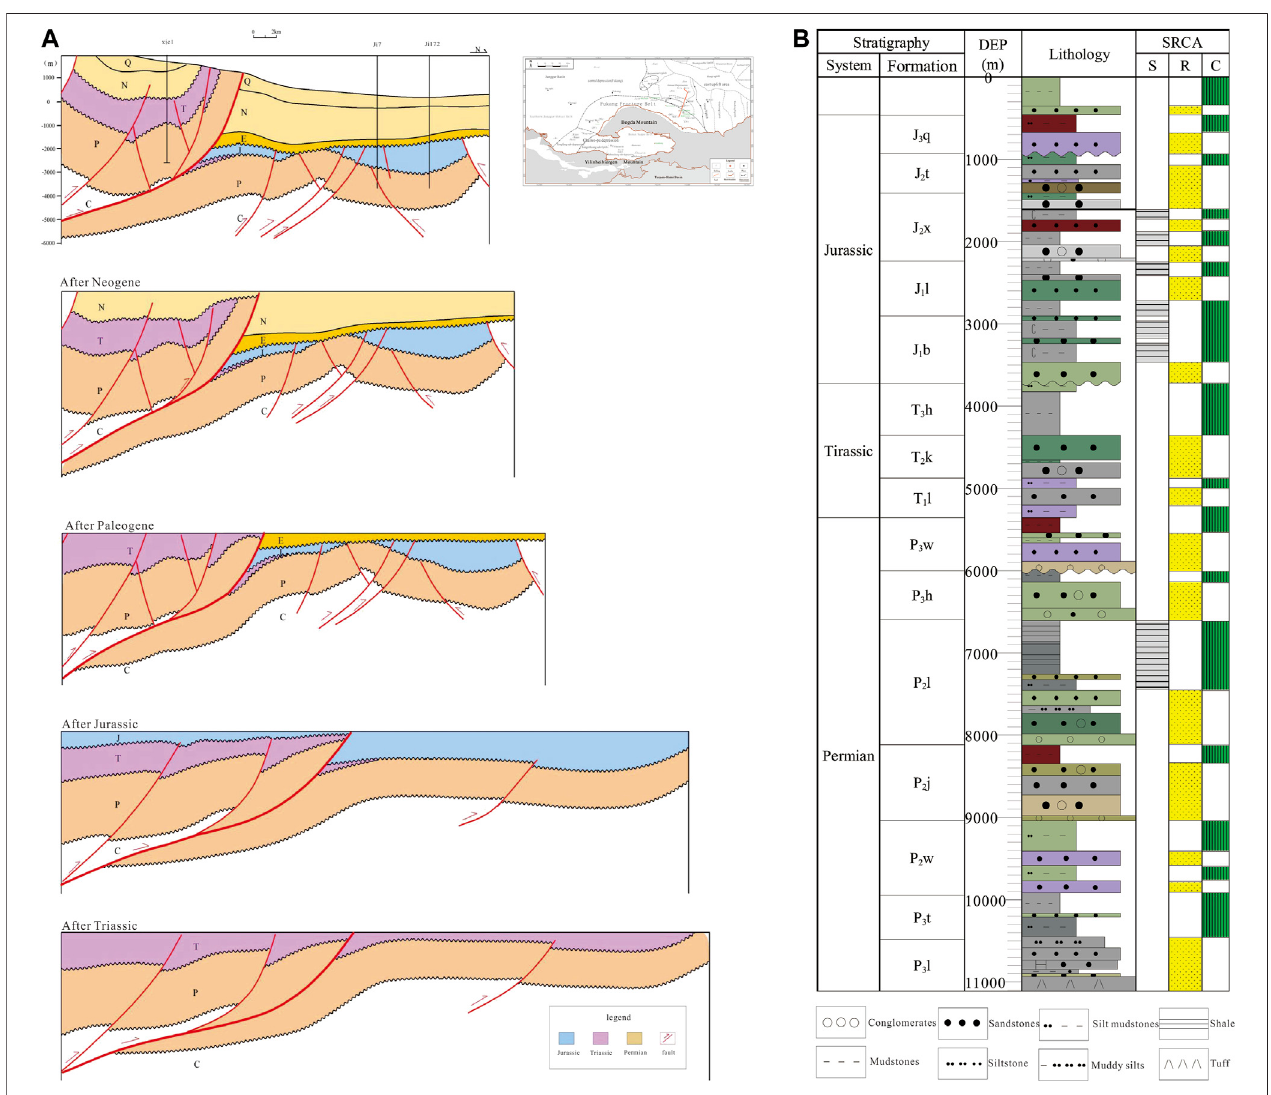
FIGURE 2 | (A) The tectonic evolution of the periphery of the Bogda Mountain; (B) Chronostratigraphy of southern Junggar Basin.